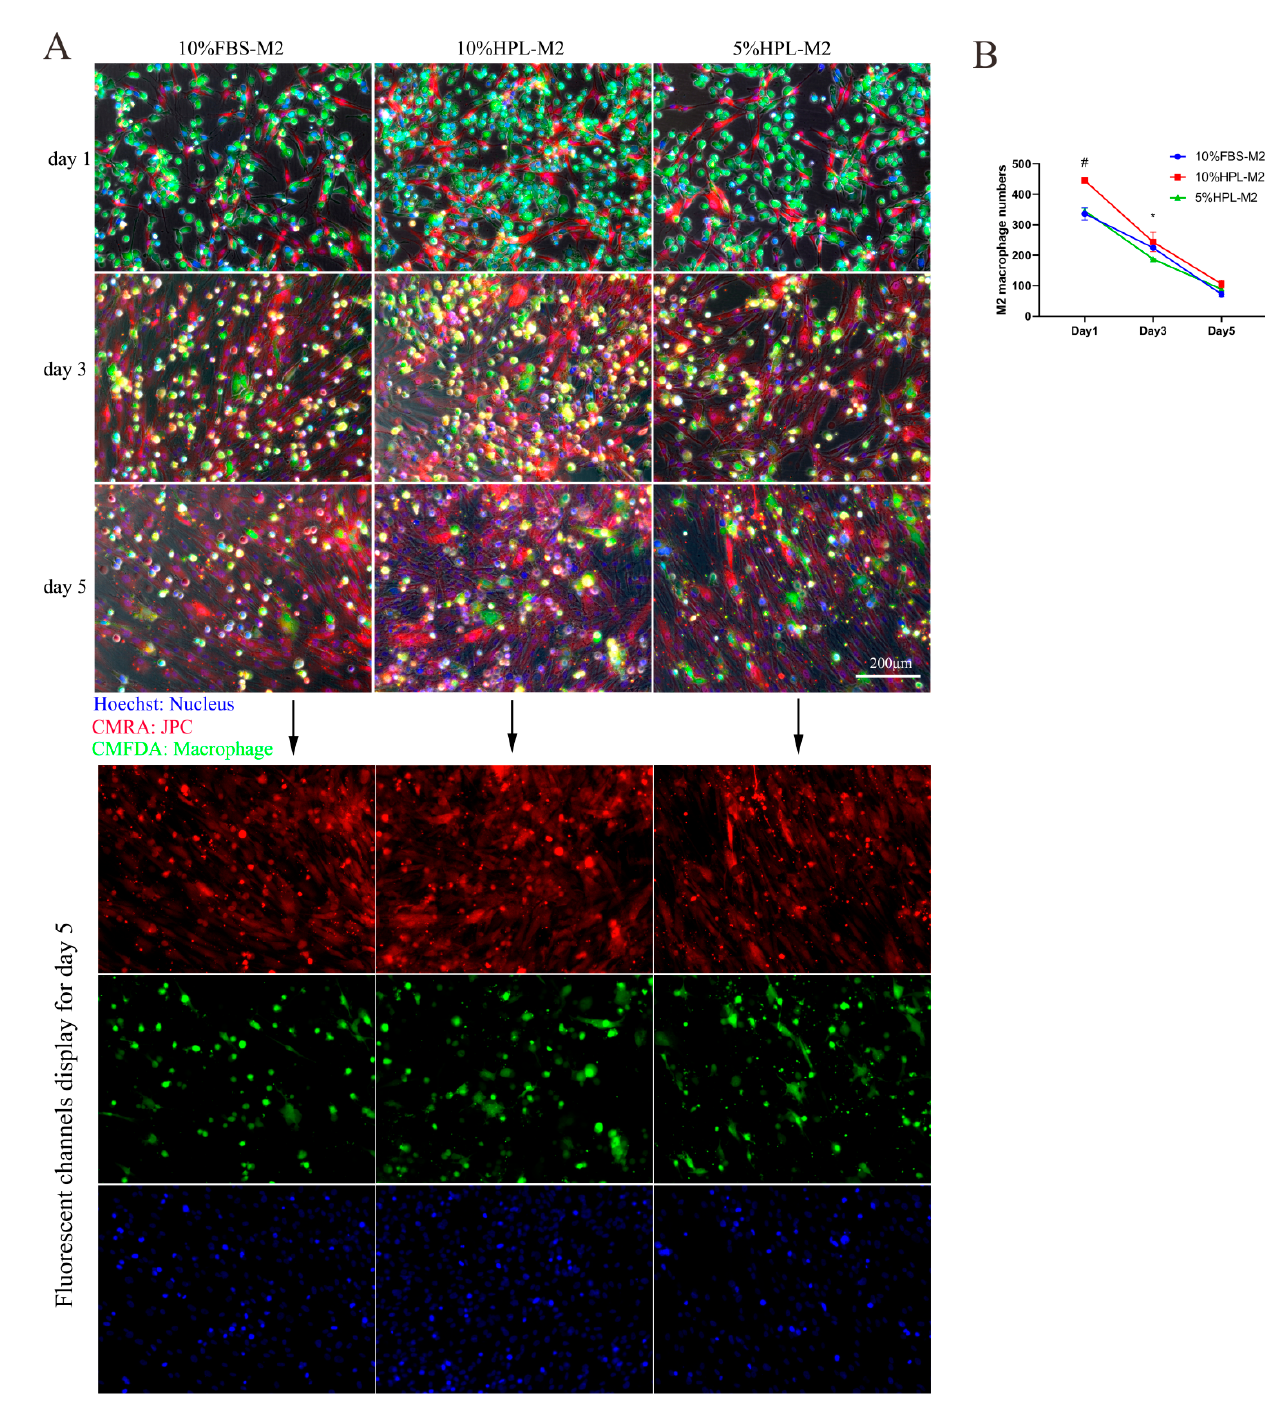
first, third, and fifth days of coculture (blue: nucleus; red: JPC; green: macrophage); scale bar: 200 μ m. ( B ) M1 macrophage numbers counted in the fluorescence images at days 1, 3, and 5 of coculture with JPCs ( n = 3, 5% hPL compared with 10%